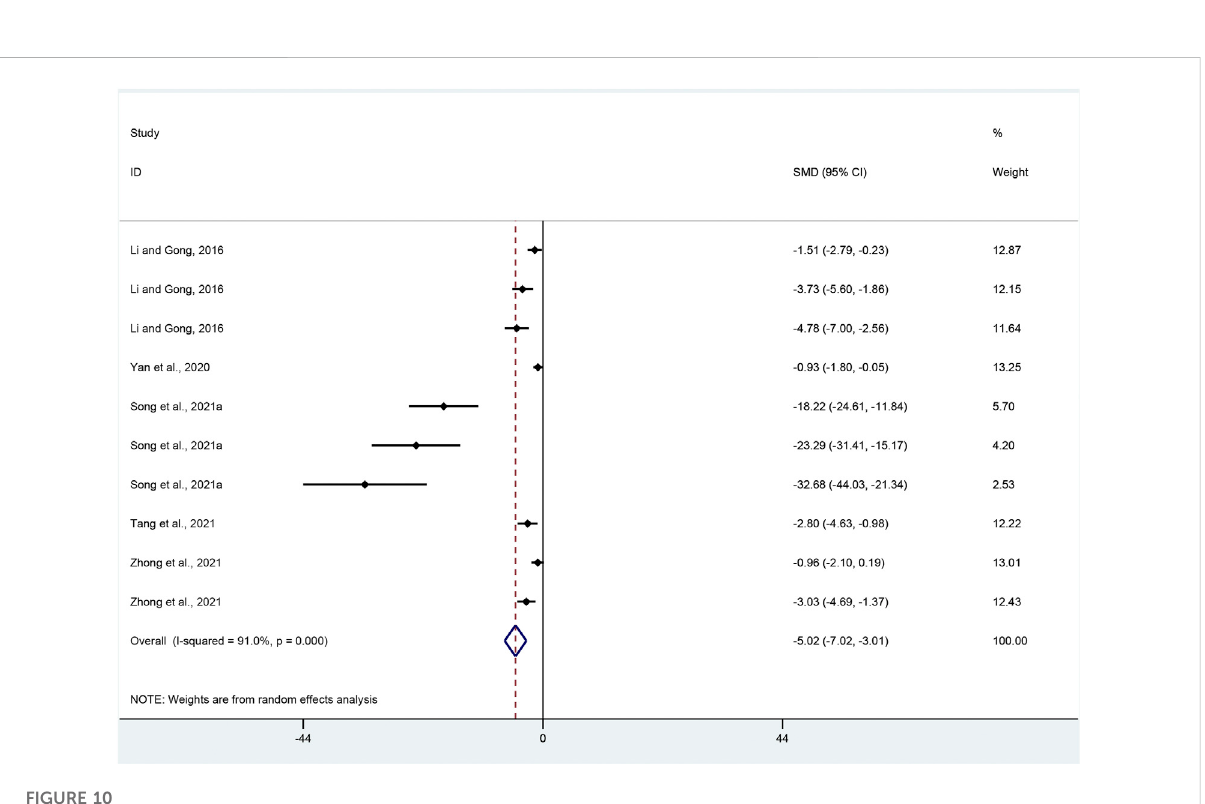
FIGURE 10 Pooled estimate of MDA with